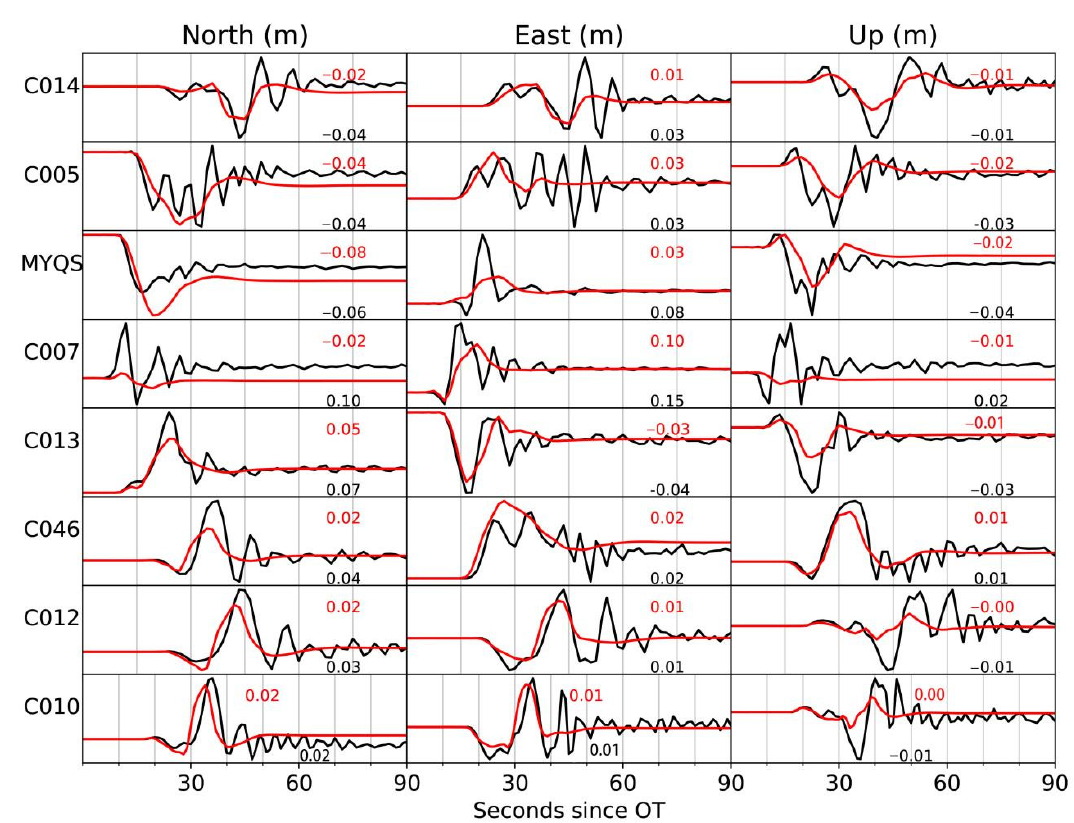
Figure 9. Data fitting using the preferred rupture model (Figure 7) of the 2022 Menyuan earthquake between the displacement waveforms (black lines) and model predictions (red lines). The peaks of corresponding data are marked on each subplot.